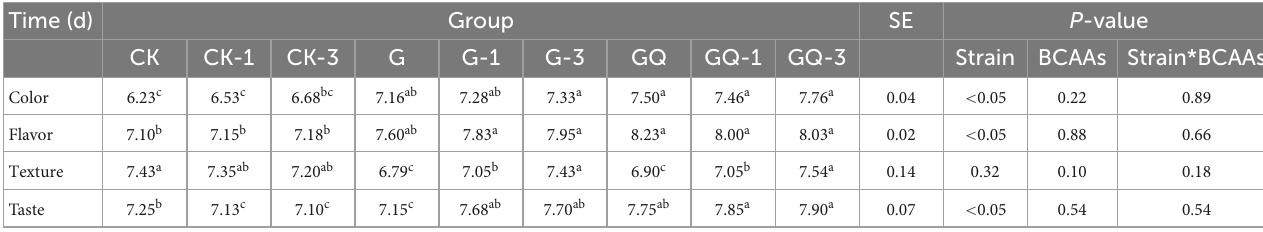
*Indicatestheinteractionbetweenstrainsandbranched-chainaminoacids.Differentsuperscriptletters(a–c)indicateasignificantdifferenceamongtreatmentgroups( P